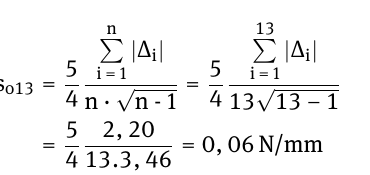
The table of Student’s t-distribution critical values [10, page 35] assigns Student’s coefficient, t α , n = 3.06 to risk, α = 1% and number of measurements, n = 1. Limit error, χ α , n [N/mm] is calculated in relation (2) [11].